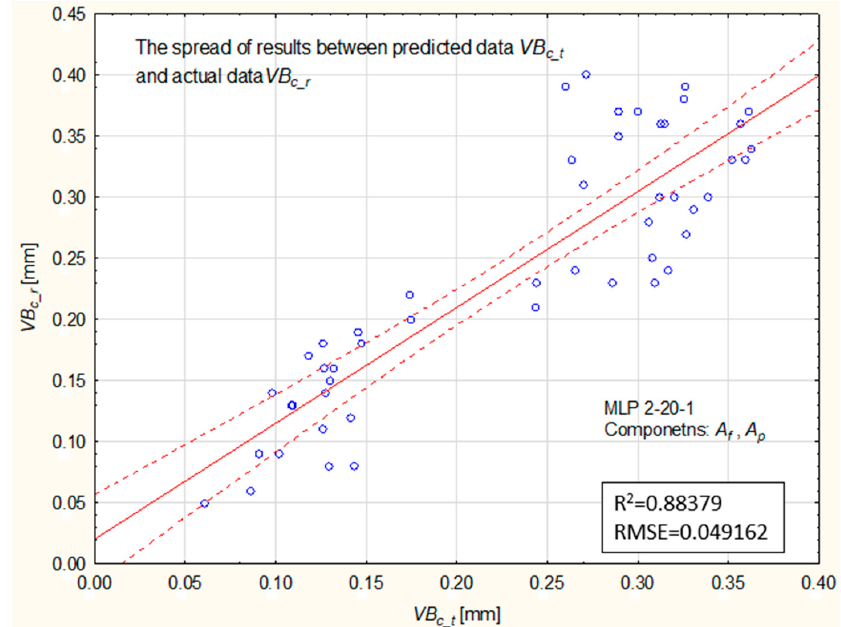
Figure 11. Comparison of predicted values, VBc_t, with experimental data, VBc_r, at the validation stage (MLP 2-20-1).